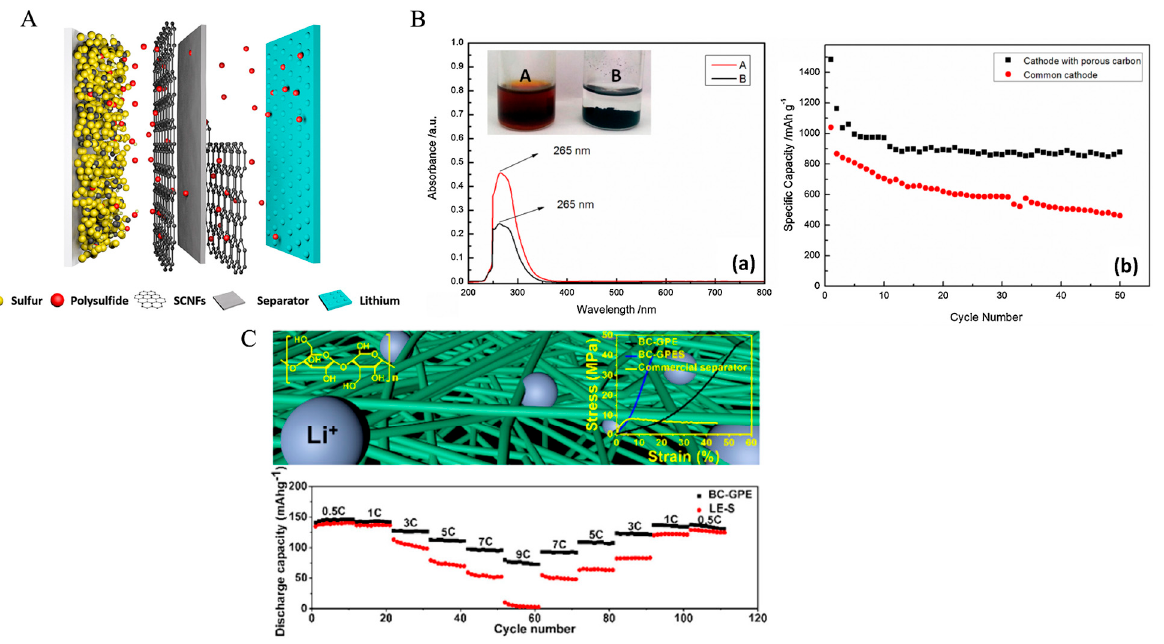
Figure 5. Various biopolymers utilized for synthesis of lithium-based energy storage devices. ( A ) Carbonized silk layer for lithium battery separators to reduce polysulfide transport [93]. ( B ) Porous carbon scaffold derived from fish collagen for lithium battery cathodes to extend battery performance by ( a ) reduced polysulfide absorption and ( b ) increased specific capacity [124]. ( C ) Cellulose gel for lithium battery electrolyte to limit anode dendrite growth and promote battery function [125]. Reproduced with permissions (( A ). Copyright 2019 Elsevier; ( B ). Copyright 2014 Elsevier; ( C ). Copyright 2018 American Chemical Society).